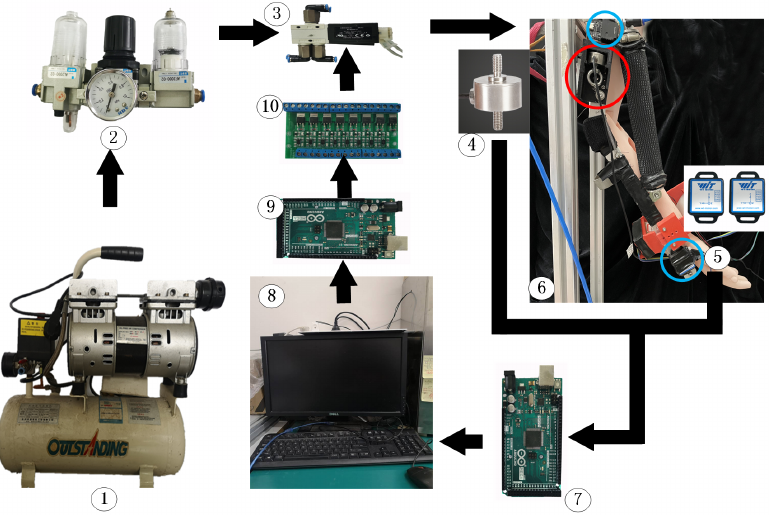
Figure 11. Experimental setups: one-air source; two-air filter regulator; three-high-speed valve; four- force sensor (used to calculate the joint torque); five-inertial measurement unit (IMU); six-one-DOF exoskeleton and a manikin arm; seven-microcontroller(Arduino Mega 2560, employed for signal acquisition); eight-host; nine-microcontroller (Arduino Mega 2560, used for transmitting the control signal); ten-printed circuit board (adopted to drive the high-speed valve).